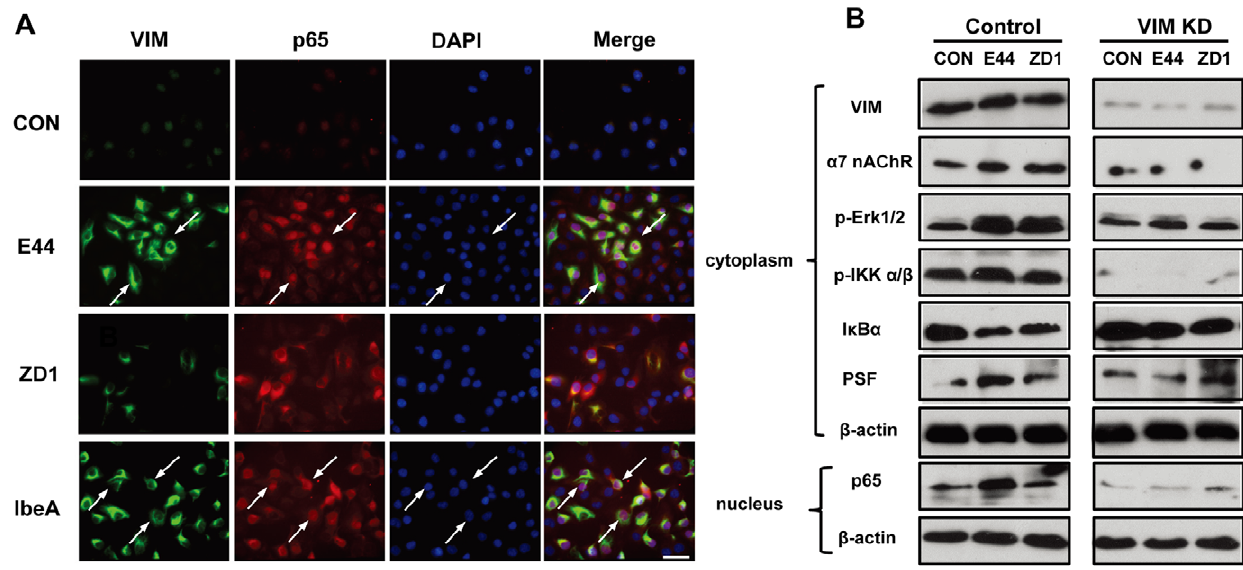
Figure 3. Role of vimentin in IbeA + E.coli K1-induced NF- k B activation. ( A ) Immunofluorescence microscopy was used to examine the correlation between vimentin reorganization and NF- k B translocation to the nucleus after 2 h of stimulation with IbeA protein (0.1 m g/ml), E44 or ZD1 (25 MOI). HBMECs were triple-stained with the V9 antibody against vimentin conjugated to FITC (green), the rabbit antibody against NF- k B (p65) conjugated to rhodamine (red), and DAPI (blue). The merged images are shown in the right-hand panels (Merge). Arrows indicated cells with colocalization of vimentin and NF- k B (p65) Scale bar, 50 m m. ( B ) Blockage of IbeA + E. coli K1-induced NF- k B activation in HBMECs by siRNA-mediated knockdown of vimentin. HBMECs were transfected with vimentin or control siRNA as described in Materials and Methods. After 24 h incubation, the cells were treated with E44 or ZD1 (10 7 /ml) for 30 min or 2 h. Vimentin (VIM), a 7 nAChR, ERK1/2 phosphorylation (p-Erk1/2), IKK a / b phosphorylation (p-IKK a / b ), I k B a degradation, and PSF re-localization were examined in cytoplasmic fractions after 30 min of stimulation with E. coli K1 strains. NF- k B (p65) translocation to the nucleus was examined in nuclear fractions after 2 h of incubation with E. coli K1 strains. b -actin in both fractions was detected as internal loading controls. Control: HBMECs transfected with control siRNA; VIM KD: HBMECs transfected with vimentin siRNA; UNT: Untreated HBMECs.